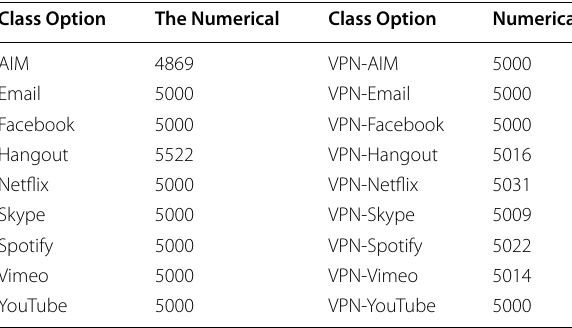
Table 1 The data used In ISCX-VPN-NonVPN-2016